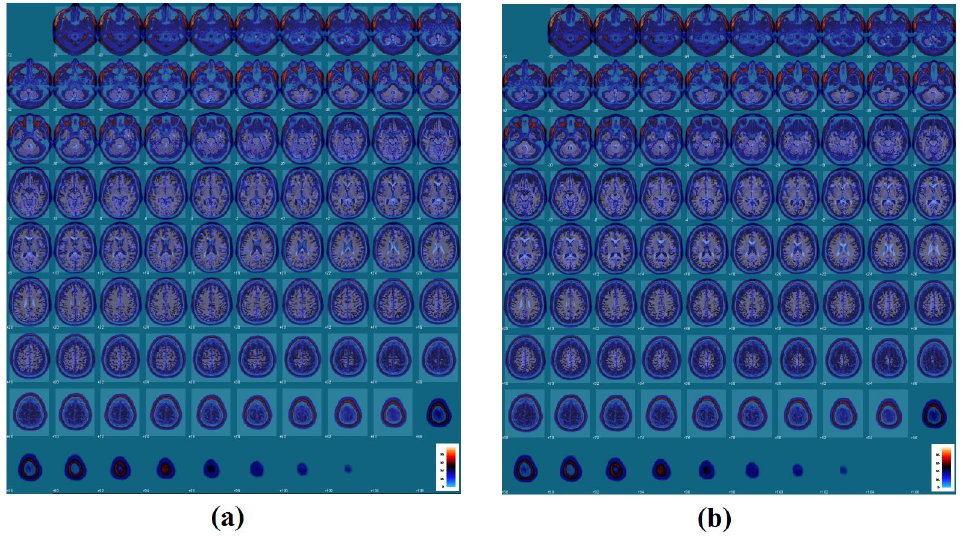
Figure 2. Example of preprocessed and overlaid subjects’ scans with the AAL atlas template from each studied group where ( a ) is for a normal subject, while ( b ) is for a mildly cognitive impairment